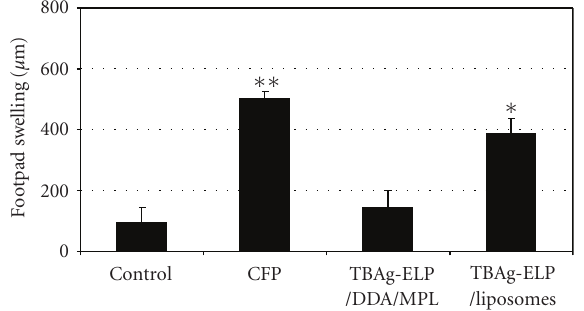
Figure 7: Delayed-type hypersensitivity response in TBAg-ELP and CFP-immunized mice. Groups of 4 mice were immunized, as described above, with 10 μ g of TBAg-ELP mixed with DDA/MPL or loaded in liposomes. The positive control group was injected with 10 μ g of CFP/DDA/MPL and the negative control group with 0.9% NaCl. A skin test was performed on each animal on day 56 to evaluate the delayed-type hypersensitivity (DTH) reaction. Mice received an intradermal injection of 10 μ g of M. bovis PPD (in 40 μ L of 0.9% NaCl) into the right-hind footpad and, as a control, 0.9% NaCl into the left-hind footpad. The diameter of the specific swelling was measured 24 h later and data were expressed as the mean ( ± SD) of the di ff erence between right and left footpads for each group of mice ( n = 4). The statistical analysis compared (1) the CFP group versus the negative control group and (2) the TBAg/liposome group versus the TBAg/DDA/MPL group and the negative control group. P -values less than .05 were considered significant ( ∗ ) and less than .01 highly significant ( ∗∗